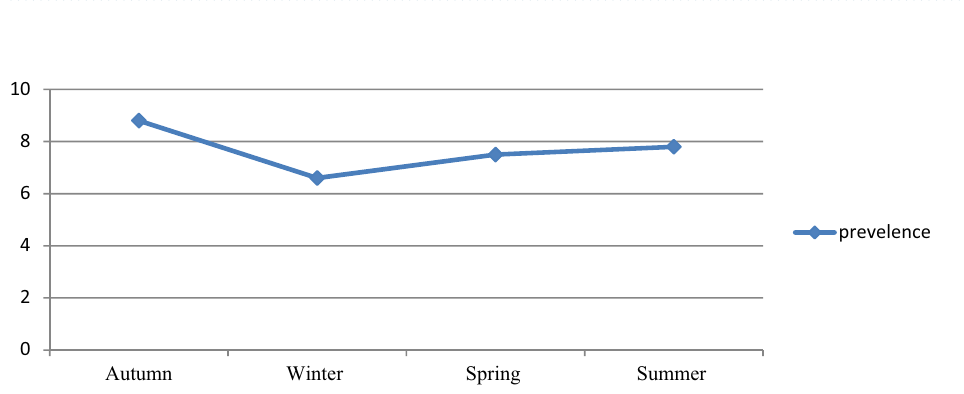
Table 3. Sex, age and seasonal variations of malaria prevalence and associated factors among patients requested for malaria examination at University of Gondar Specialized Referral Hospital from 2014 to 2019.